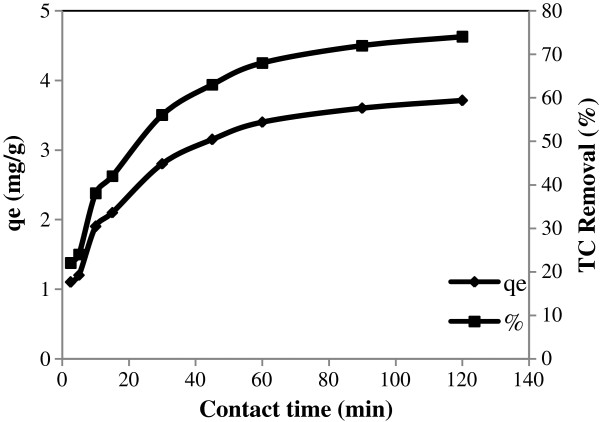
Effect of contact time on TC adsorption.